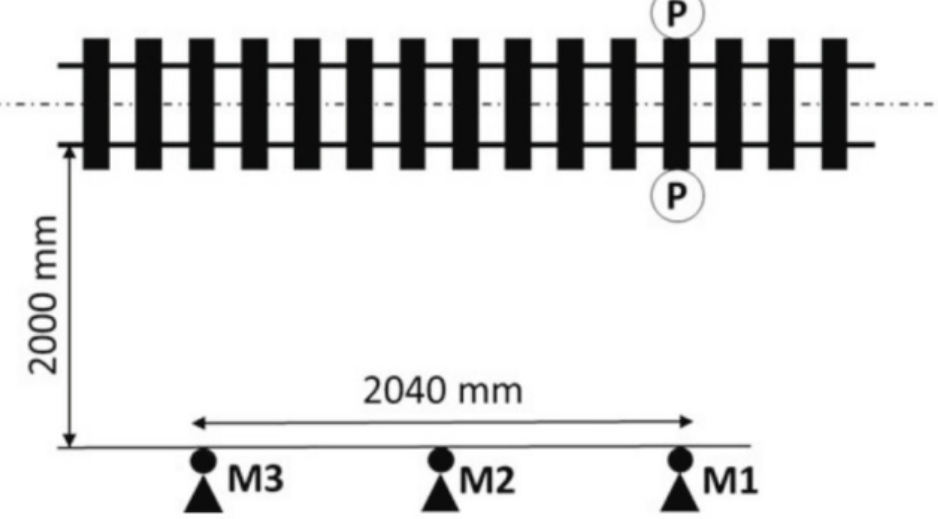
Figure 9. The scheme of measuring positions in the pass-by test; M—Microphones, P—photocells [89].